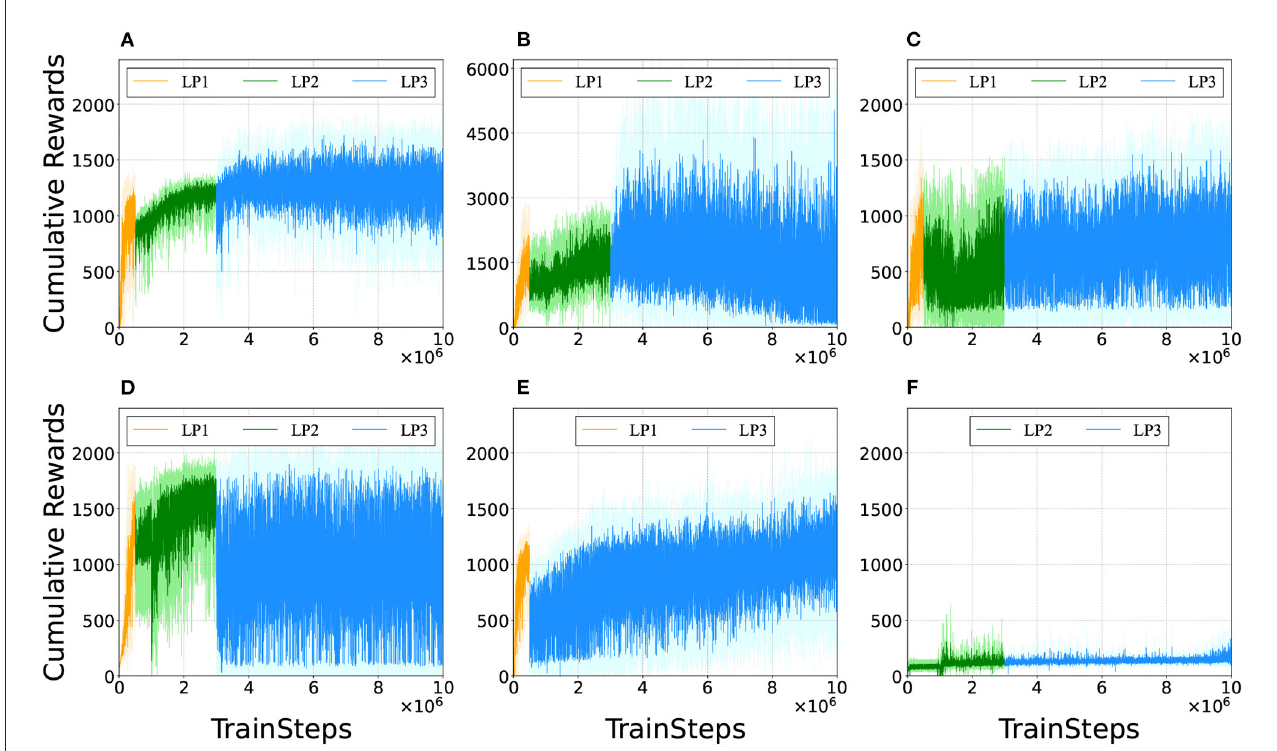
FIGURE13 Comparison of learning curves. We evaluated the policies every 1,000 training time steps by testing the performance for one episode (the maximum ω v ) from Equation (2), i.e., the reward function was changed to length being 1,000 time steps). (A) Proposed method. (B) Excluding 1 / (1 + r ( s t , a t ) E t E t x f forward f alive f support . 1 / (1 ω E ω v ω v ) normalizes the value among the rewards that vary widely due to velocity term ω v ˙ = − | − + + + + − 1 | + The range of ω v in LP1 and LP2 was set to [0,2.5]. The agent was trained to learn appropriate outputs for ω v ω v in LP1 and LP2 was changed to [1.5,2.5]. The agent was trained to learn appropriate outputs for larger ω v first than smaller ω v . (E) Without LP2. The reward function was set with LP1 parameters in the initial 500 thousand training time steps and with LP3 parameters in the rest of 9.5 million training time steps. (F) Without LP1. The reward function was set with LP2 parameters in the initial 3 million training time steps and with LP3 parameters in the rest of 7 million training time